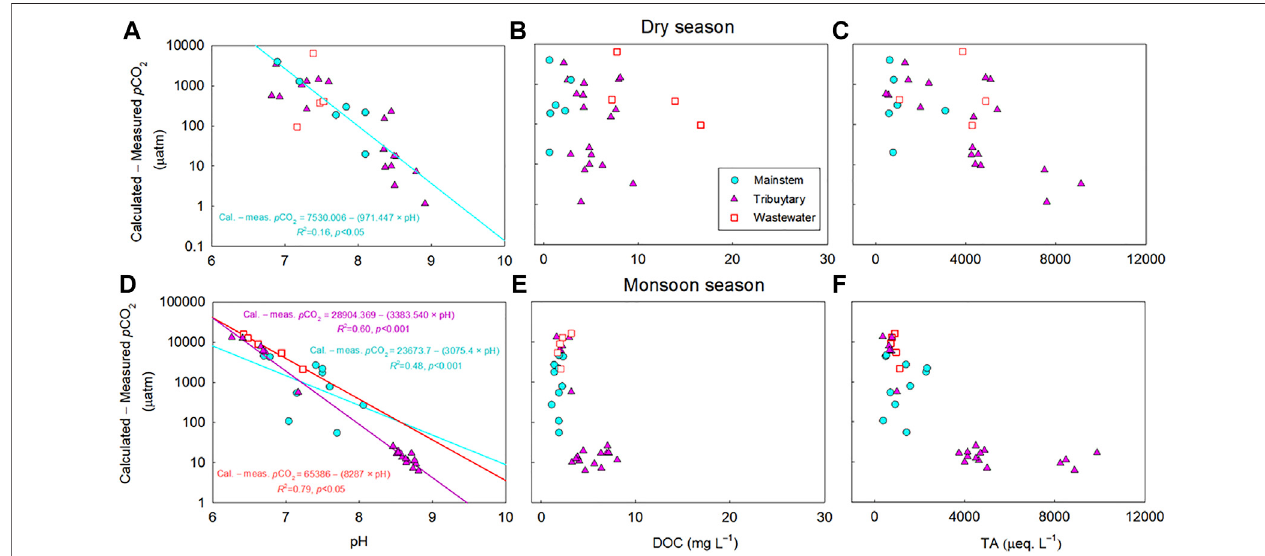
FIGURE 4 | Relationships between the calculated minus measured partial pressure of CO 2 ( p CO 2 ) and pH (A, D) , dissolved organic carbon (DOC) (B, E) , or total alkalinity (TA) (C, F) in the mainstems (M), tributaries (T), and polluted urban tributaries or wastewater ef fl uents (W) of the four large rivers during the monsoon and dry seasons. For the four large rivers, 128 data points are presented from Figure 2 (excluding 2 extreme values exceeding 25,000 µatm during the monsoon season), includingthemainstem(M)(n:29formonsoonseason;24fordryseason),tributaries(T)(n:29formonsoonseason;30fordryseason),andwastewater(W)(n:6for monsoon season; 10 for dry season) from 2015 to 2019. The signi fi cant relationship ( p < 0.05) is indicated by a regression line through the plot. The difference between calculated p CO 2 and measured p CO 2 against pH was plotted in y-axis in log-scale.